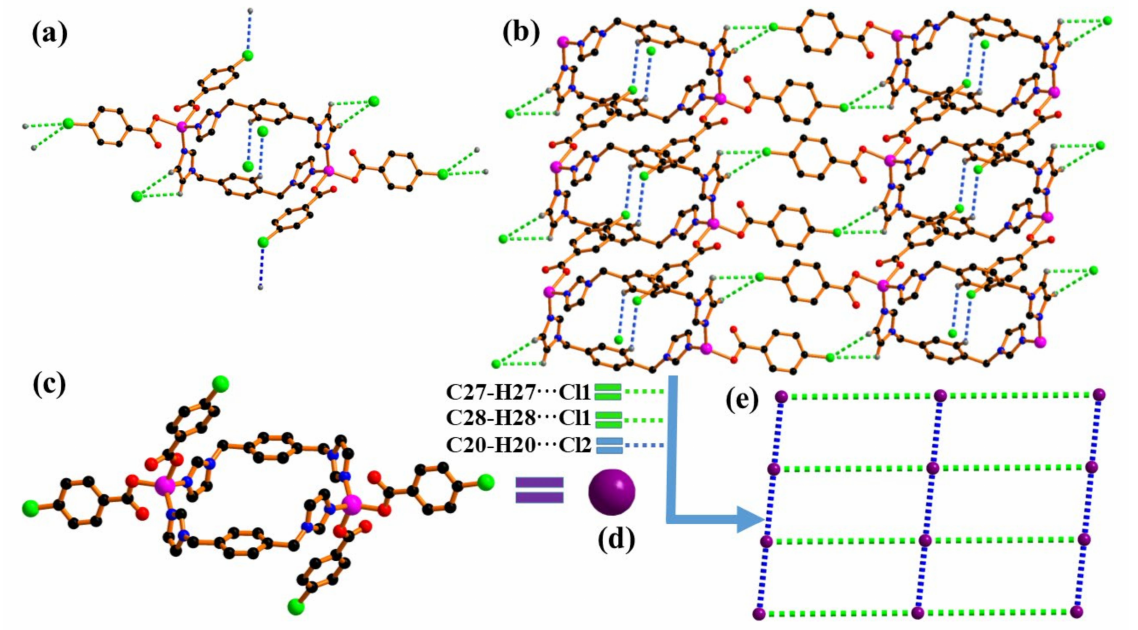
Figure 7. ( a ) The C–H ··· Cl interactions in 2 (bright green dash lines represent C20–H20 ··· Cl2 hydrogen bonds, and blue dash lines represent C27–H27 ··· Cl1 and C28–H28 ··· Cl1 hydrogen bonds). ( b ) The 2D hydrogen-bonded organic framework constructed by C–H ··· Cl interactions in 2 . ( c ) The binuclear cobalt structure of 2 . ( d ) The C–H ··· Cl interactions simplified as a linker, and the [Co 2 (pca) 4 (bimb) 2 ] simplified as a node. ( e ) The simplified Co-based HOFs in 2 .